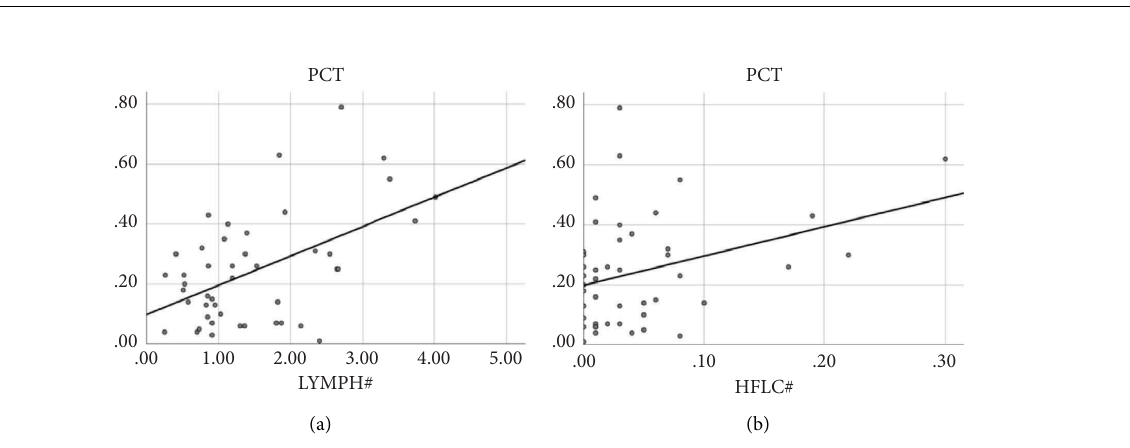
Figure 3: Correlation between leukocyte parameter and PCT. Table 6: Detection results of leukocyte parameters in admission group and discharge